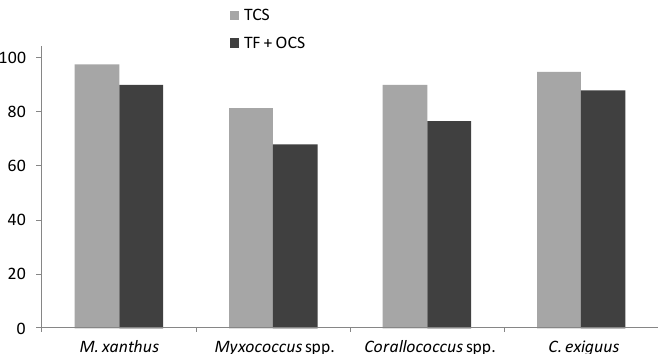
Figure 2. The percentage of RRs and TFs + OCSs found in the pan-genome core for the four groups of genomes.